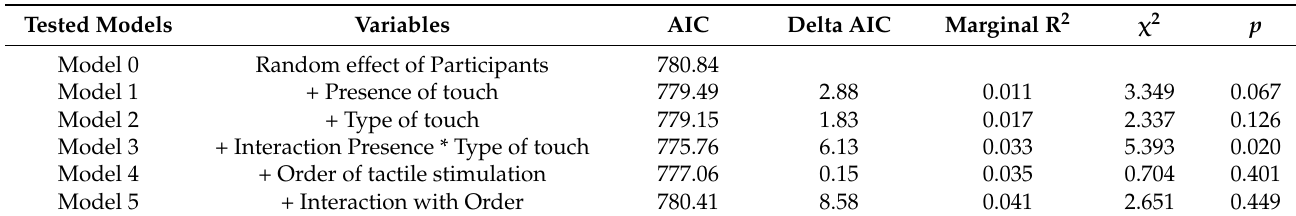
Table 3. Comparison between models predicting RMSSD. Note that smaller values of AIC indicate better fitting models. Tested Models